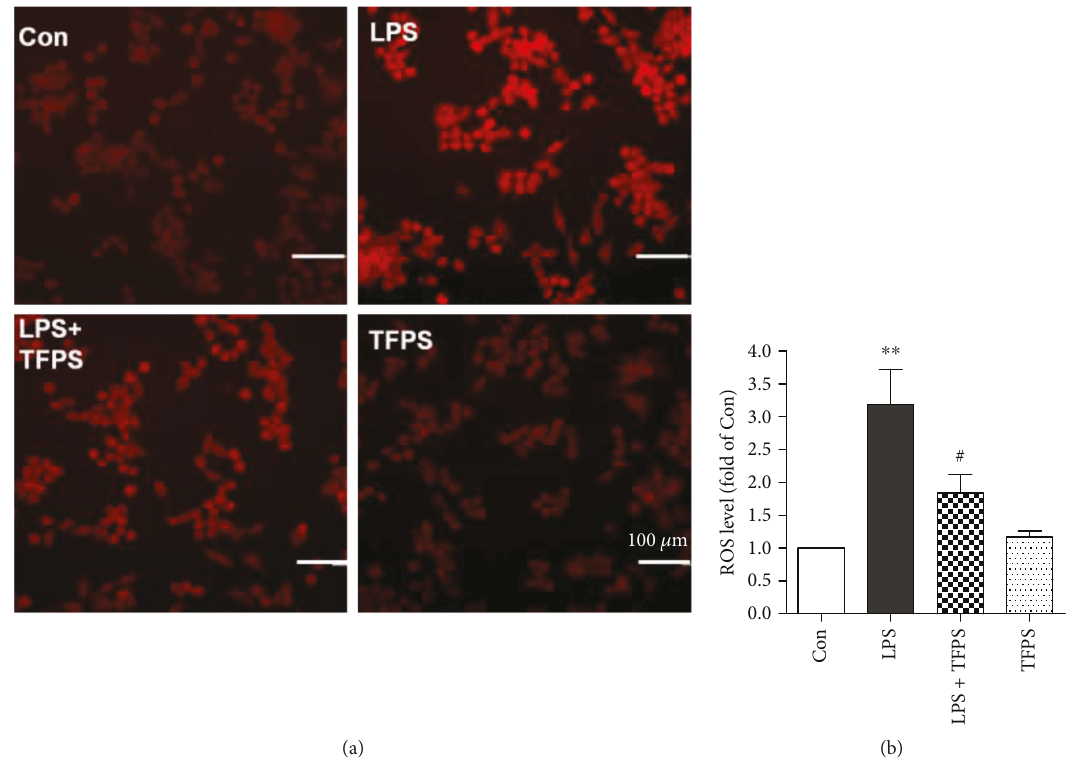
Figure 4: TFPS relieves LPS-induced RAW264.7 cell injury by attenuating oxidative stress. (a) DHE staining of control, LPS-treated (1 μ g/ml), TFPS-treated (200 μ g/ml), and TFPS-pretreated (200 μ g/ml) plus 1 μ g/ml LPS-treated (LPS +TFPS) cells. (b) The average levels of the ROS fl uorescence intensity ( n = 4 , ∗∗ P < 0 01 versus control; # P < 0 05 versus the LPS +TFPS